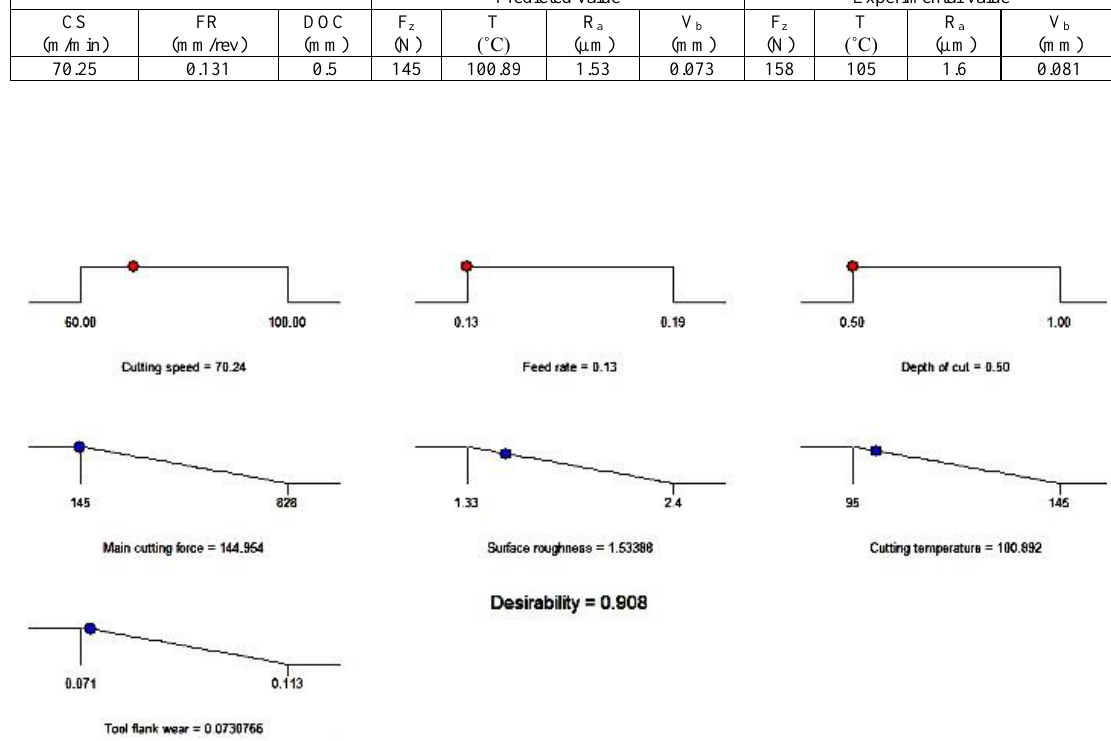
Figure 10. Ramp function graph of